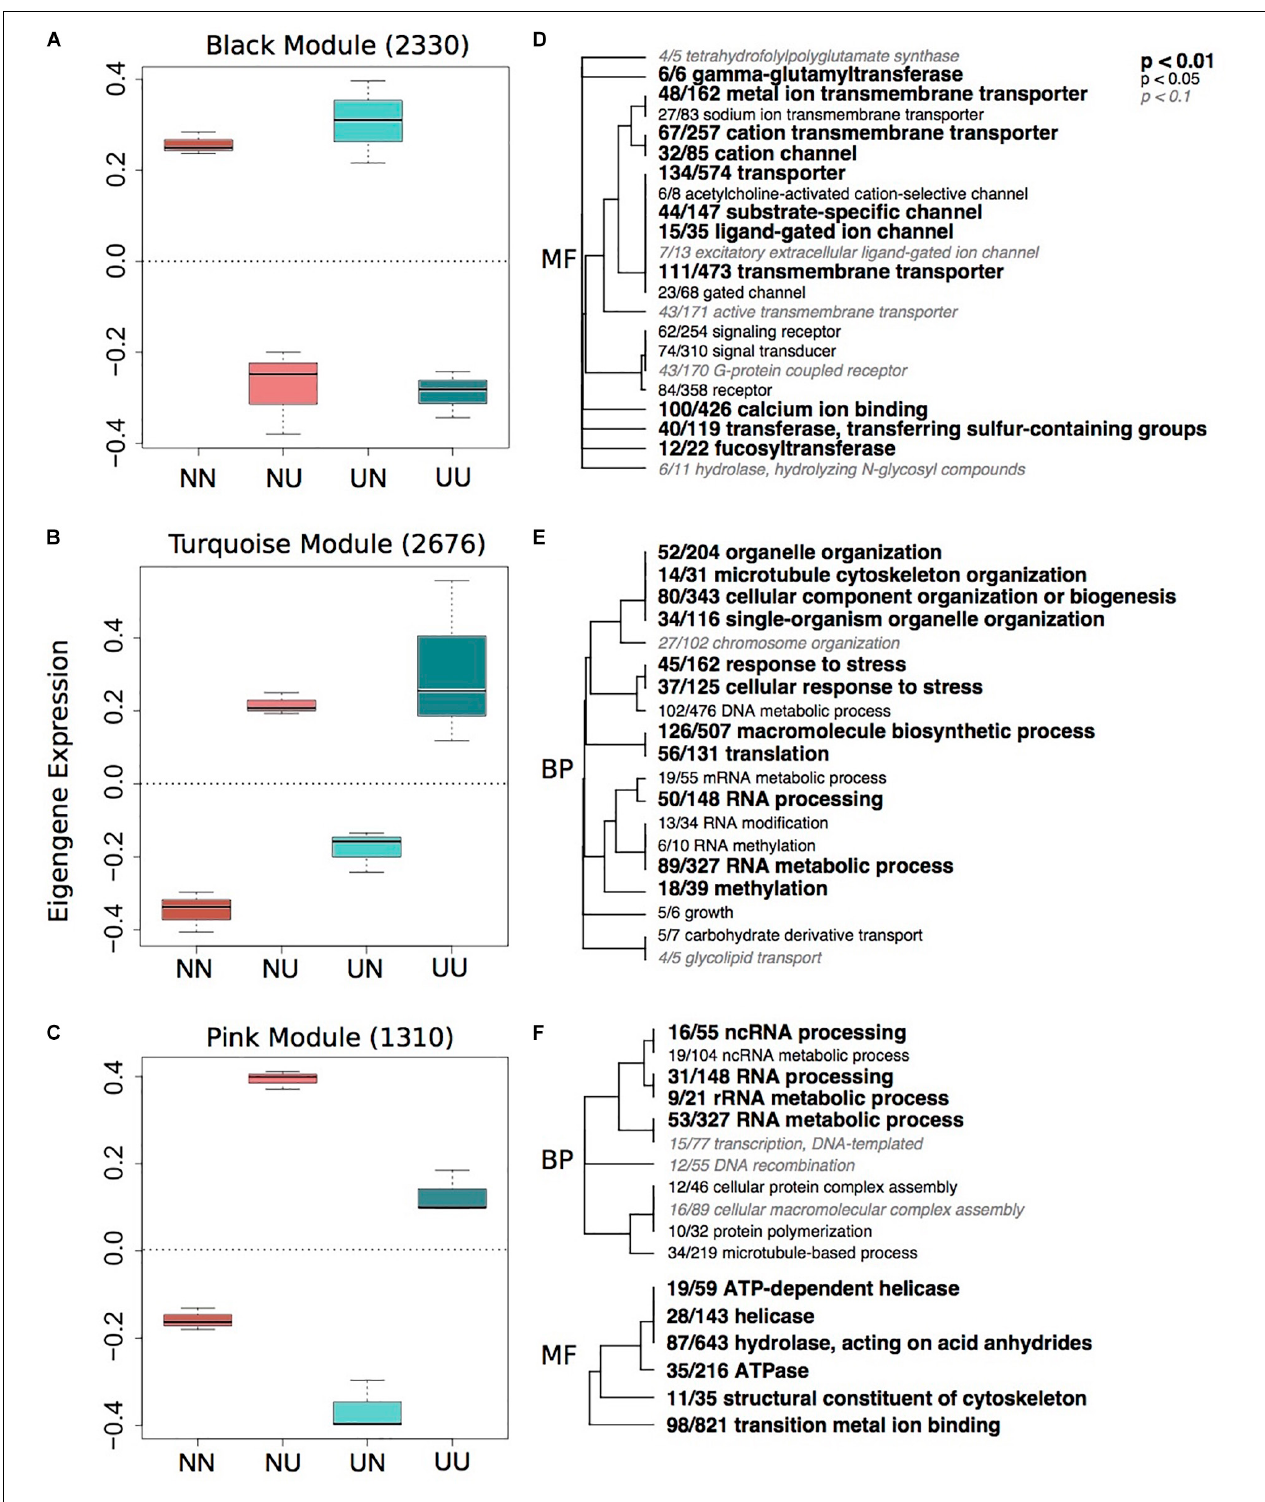
FIGURE 2 | Gene expression modules strongly correlated to developmental environment. Boxplots of eigenegene expression for the black (A) , turquoise (B) , and pink (C) modules. The number of genes represented in each module is in parentheses. Hierarchical clustering of Gene Ontology (GO) terms showing significant enrichment in the black (D) , turquoise (E) and pink (F) modules. Level of significance indicated with bold text. BP, biological processes; MF, molecular function.